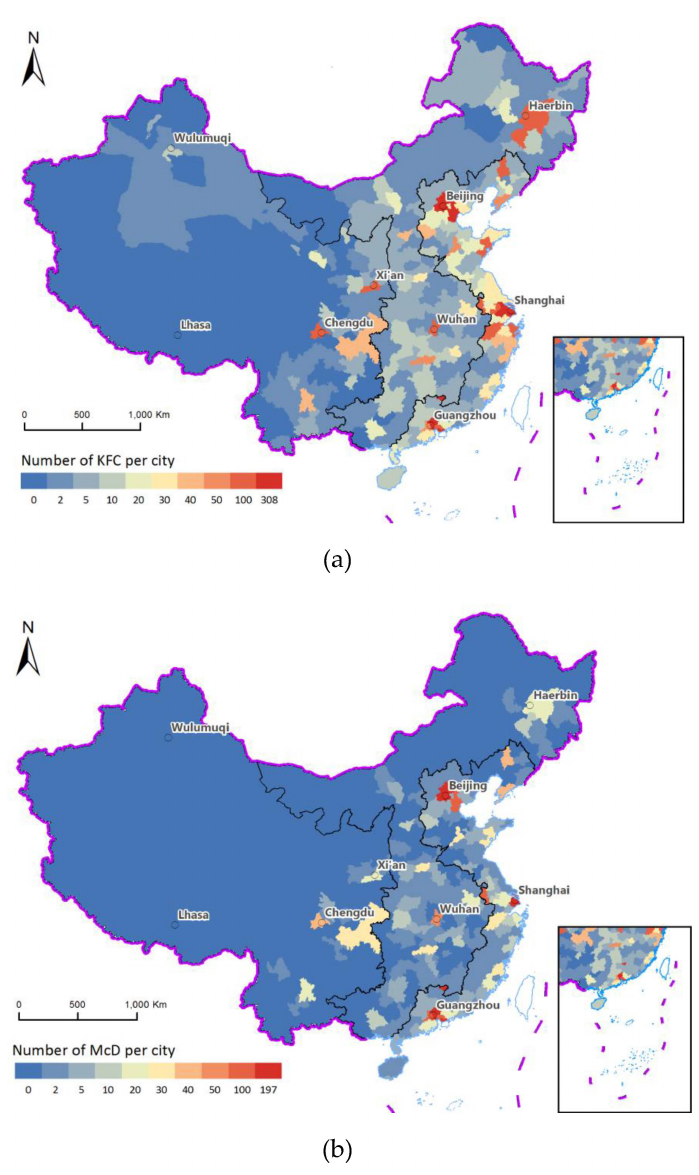
Figure 1. General distribution maps of ( a ) KFC and ( b ) McDonald’s